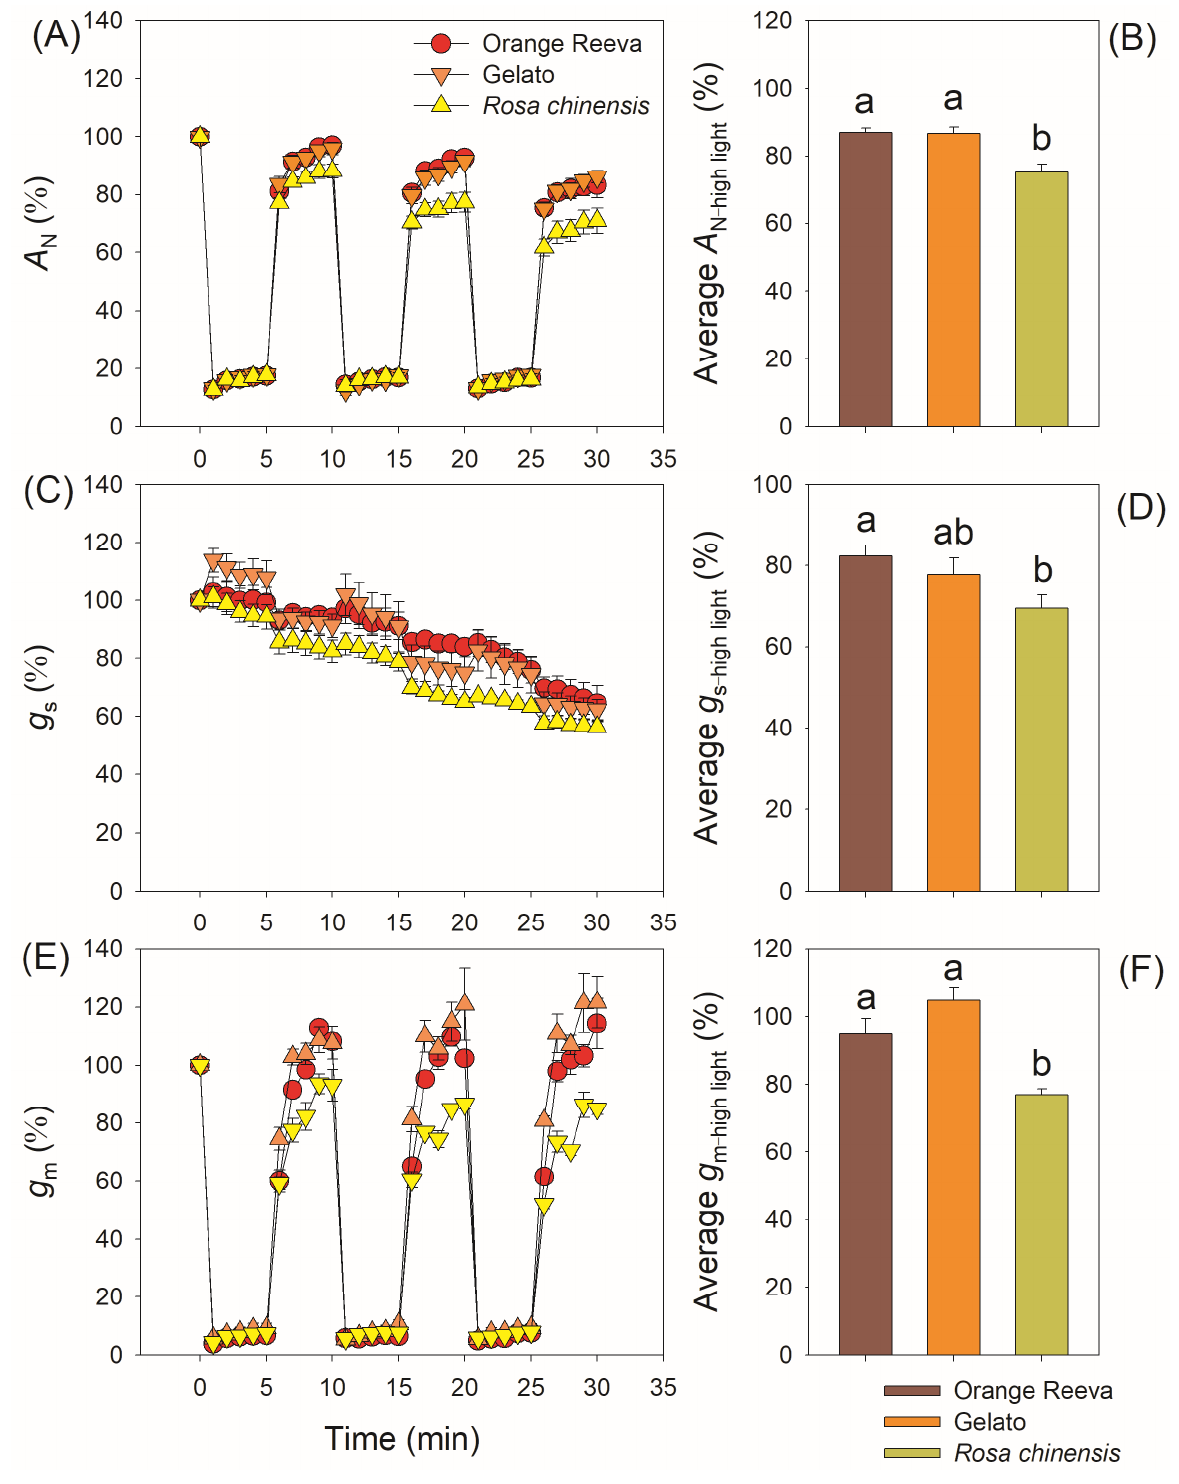
Figure 4. Relative changes and average values of in leaf net CO 2 assimilation rate ( A N ) ( A , B ), stomatal conductance ( g s ) ( C , D ), and mesophyll conductance ( g m ) ( E , F ) under fluctuating light in two modern rose cultivars (Orange Reeva and Gelato) and the old Chinese rose plant Rosa chinensis . Adapted leaves were exposed to four repeated cycles of 100 and 1500 µ mol photons m − 2 s − 1 (every 5 min). Relative values were calculated as the percentage of the initial steady-state value. Data are means ± SE ( n = 5).